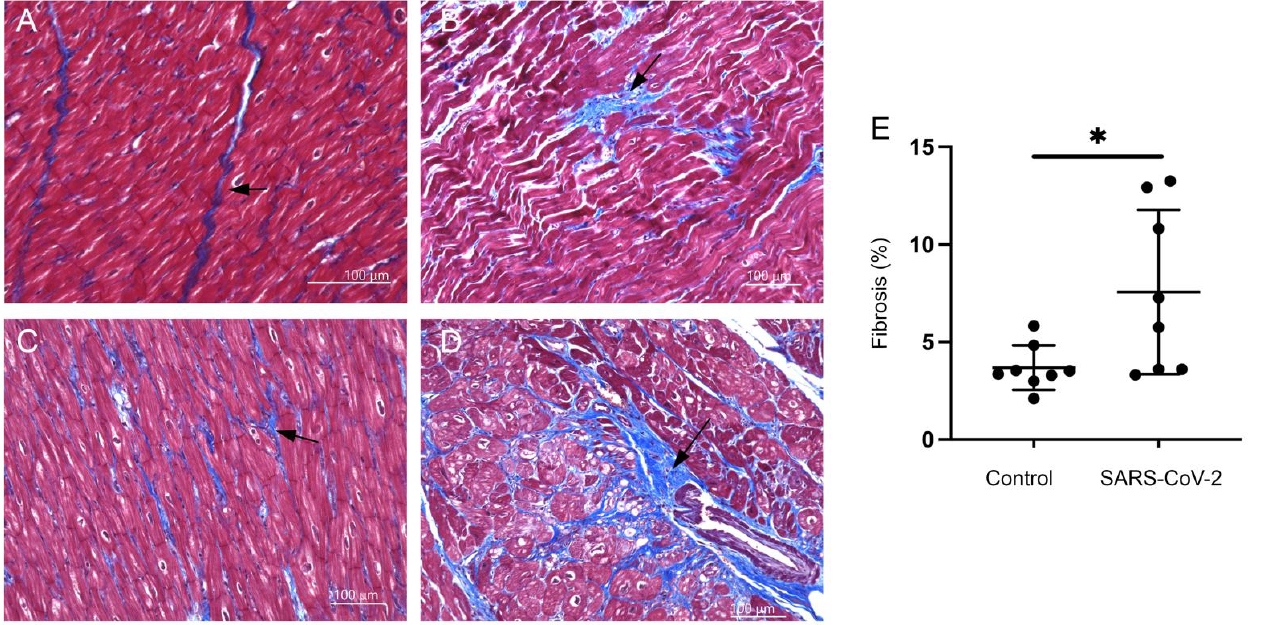
Figure 2. SARS-CoV-2 infected monkeys display increased areas of interstitial and perivascular fibrosis. Masson’s trichrome stain for fibrosis (blue) was done on ( A ) control and ( B – D ) SARS-CoV-2 infected hearts. Images show cardiomyocyte disarray and infiltration of fibrotic cells in the left ventricular tissue ( B ), interstitial fibrosis ( C ), and perivascular fibrosis ( D ). ( E ) The graph shows quantitation of fibrotic areas in control and SARS-CoV-2 infected hearts (*, p -value < 0.05). Horizontal bars represent mean ± standard deviation (SD). Arrows indicate areas of fibrosis in all figures. Scale bar: 100 µ m (